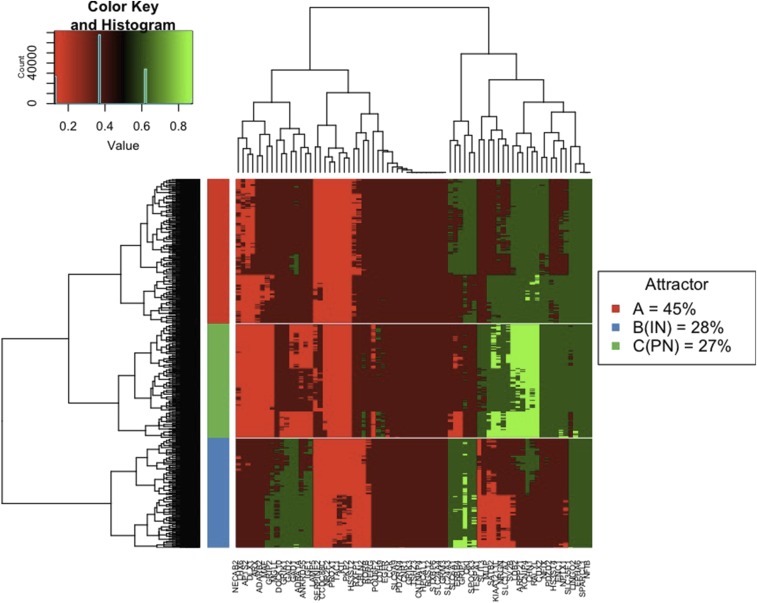
Attractor heat map for all 1082 unique attractors of the unperturbed network model. Cell states defined using quaternary intervals 0.00−0.25,0.25−0.50,0.50−0.75,0.75−1.00 and hierarchically clustered using the heatmap.2 function in R. Basin sizes for the 3 representative cell state clusters A, B and C given in legend.